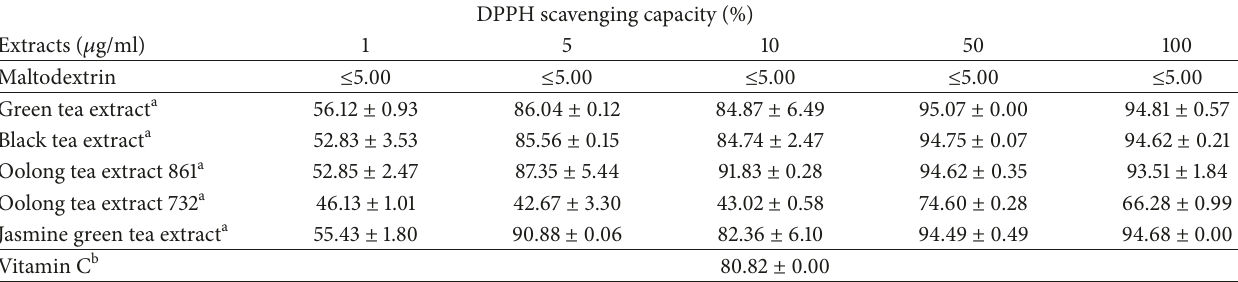
Table 1: Five different concentrations with DPPH scavenging capacity of five tea extracts.